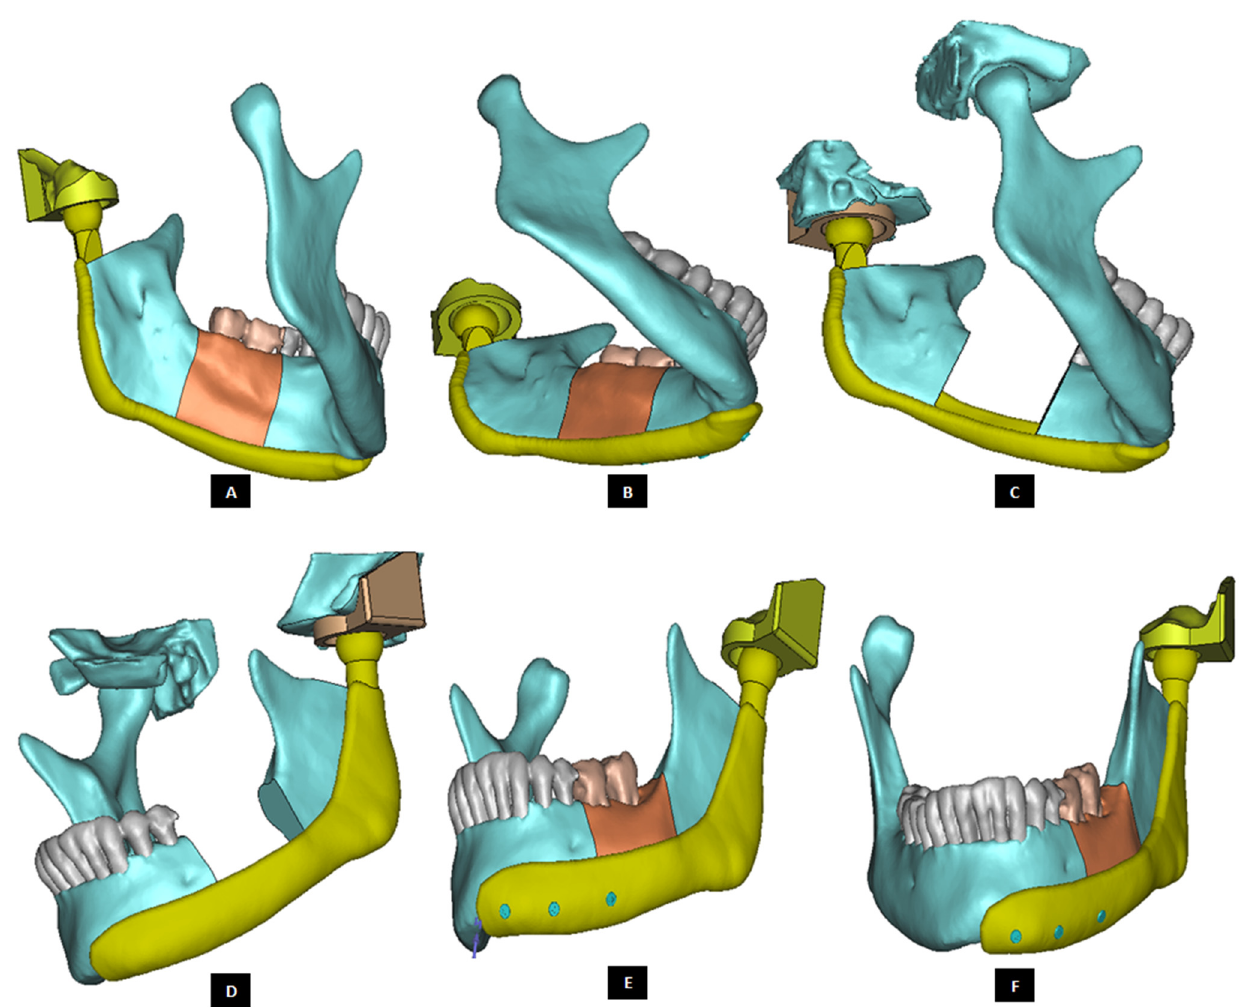
Figure 20. Shape outline of the patient-specific total TMJ prosthesis. Ramal component of the pros- thesis is extended anteriorly up to the chin ( A – F ) to support mandibular host bone and graft (with aesthetic dental implant) after removal of the imaginary tumor (shown in red) in the left mandibular body/molar region.